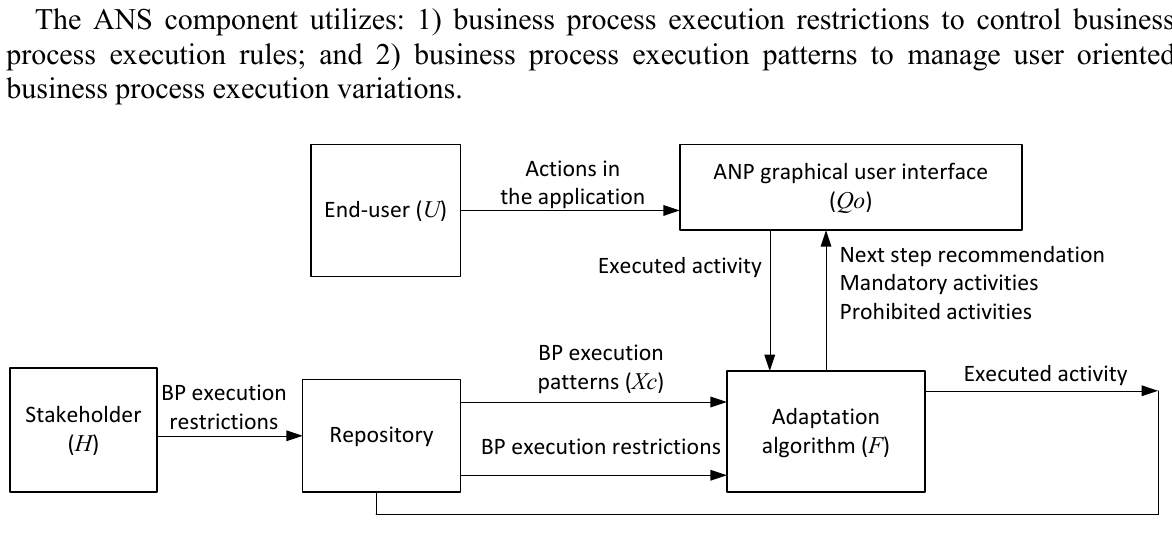
Figure 11. The adaptation algorithm’s inputs and